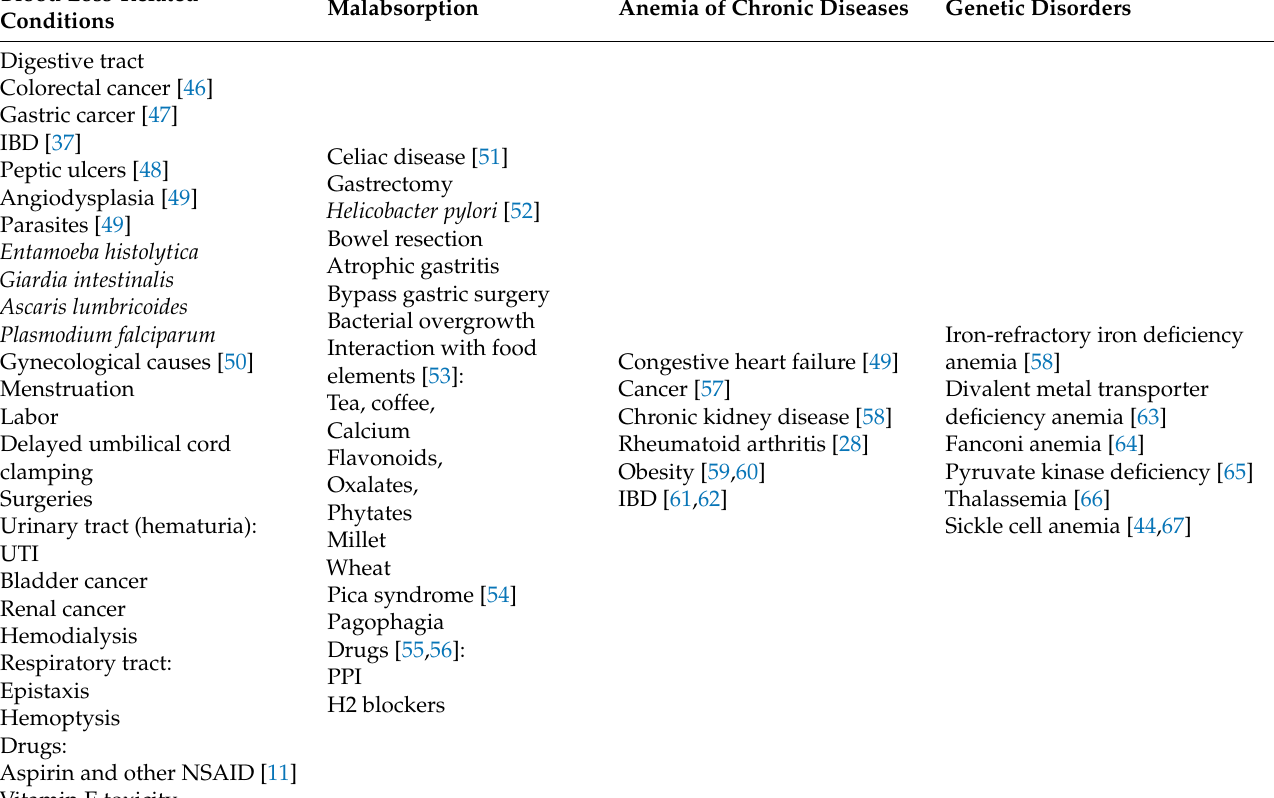
Table 2. Common pathophysiological conditions associated with IDA. The interplay between mecha- nisms participating in the development of IDA is described in Figure 3. UTI: urinary tract infection; NSAID: non-steroidal anti-inflammatory drug; H2: histamine